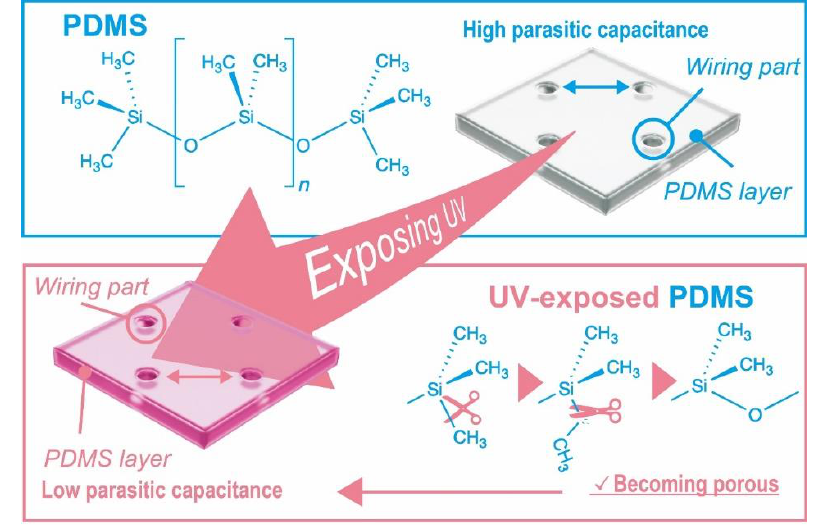
Figure 1. High parasitic capacitance caused by the wiring. The wiring will be formed inside the holes seen in the figure, which will be filled with a conductive liquid metal. Ultraviolet (UV) treatment of polydimethylsiloxane (PDMS) reduces the dielectric constant and parasitic capacitance.